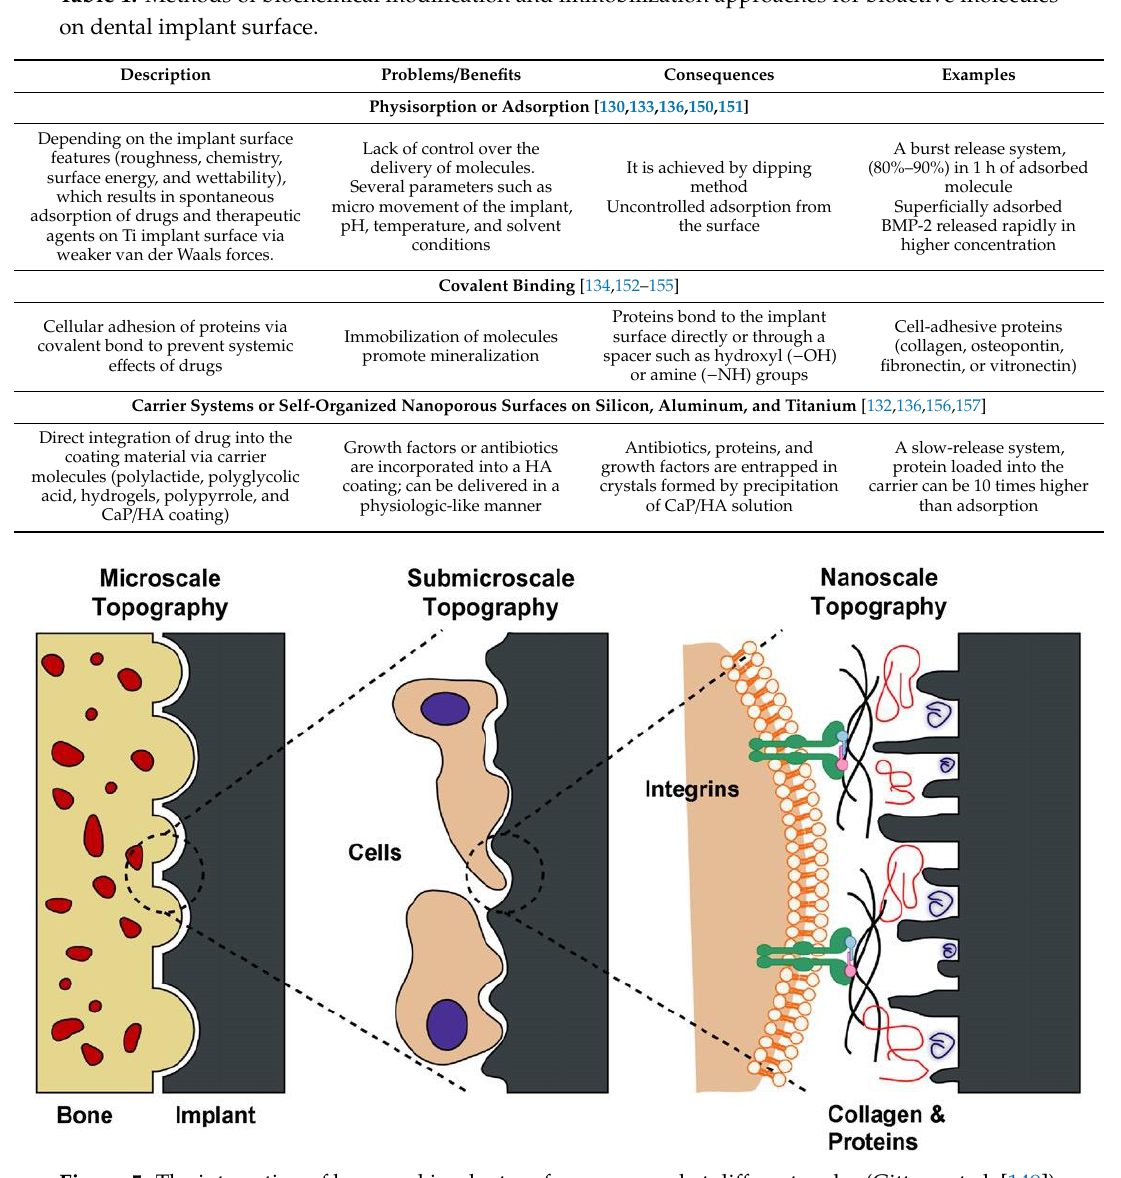
Table 1. Methods of biochemical modification and immobilization approaches for bioactive molecules on dental implant surface.